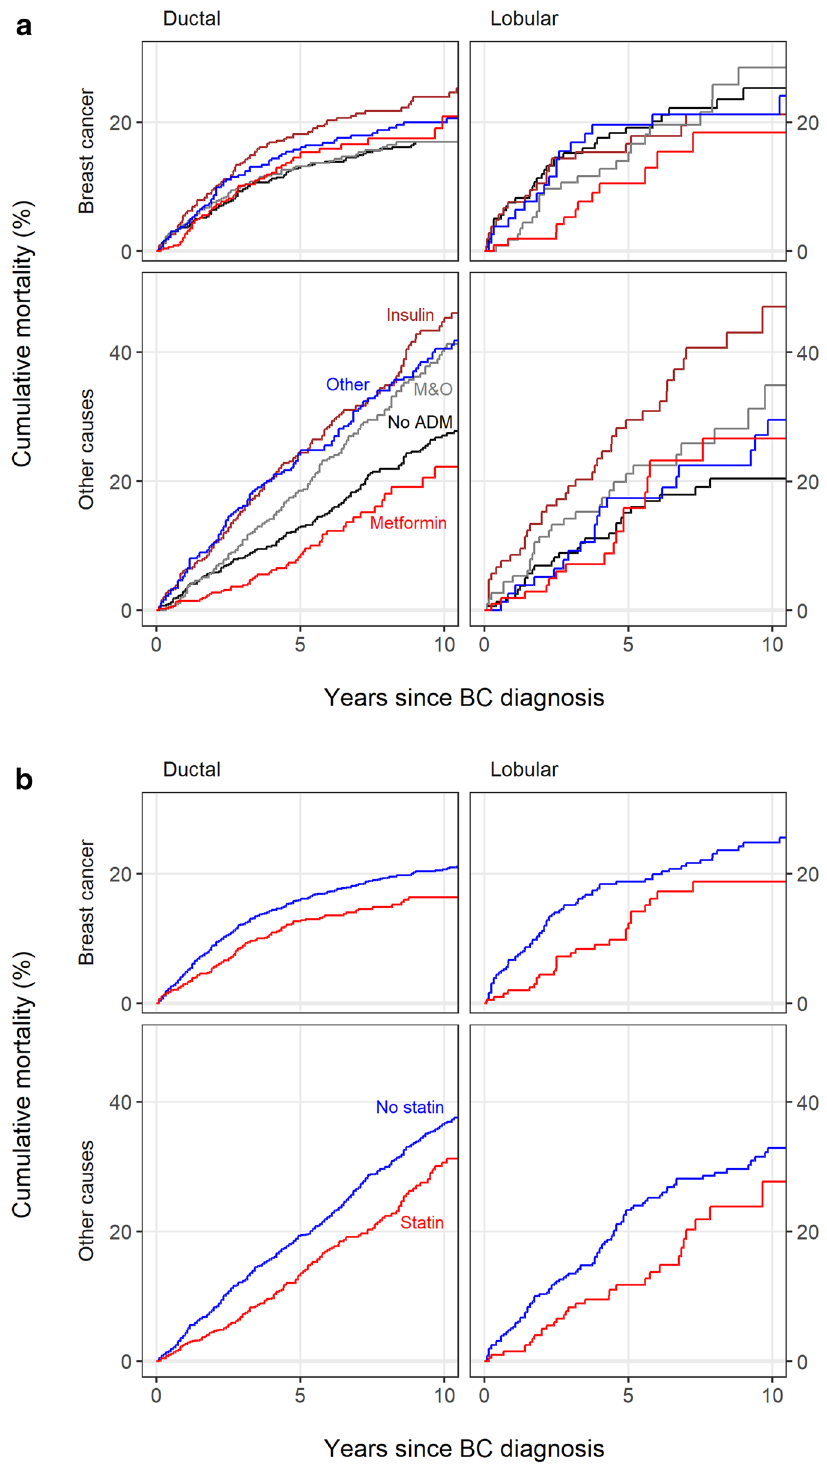
Figure 2. ( a ) Cumulative mortality curves in ADM groups amongst the invasive ductal and the lobular carcinoma. ADM = antidiabetic medication, M&O = metformin and other oral ADM. ( b ) Cumulative mortality curves in statin groups amongst the invasive ductal and the lobular